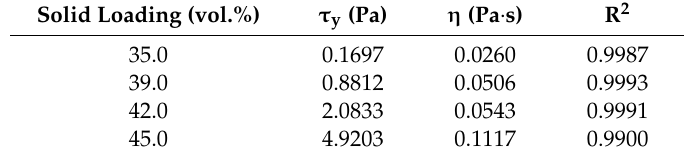
Figure 4. The τ 1 / 2 - γ − 1 / 2 dependence for determining the suspension yield stress using the Casson model. Table 1. Fitting parameters of Casson model for KNN suspensions with different solid loadings. Table 1. Fitting parameters of Casson model for KNN suspensions with di ff erent solid loadings. Solid Loading (vol.%) Solid Loading (vol.%)